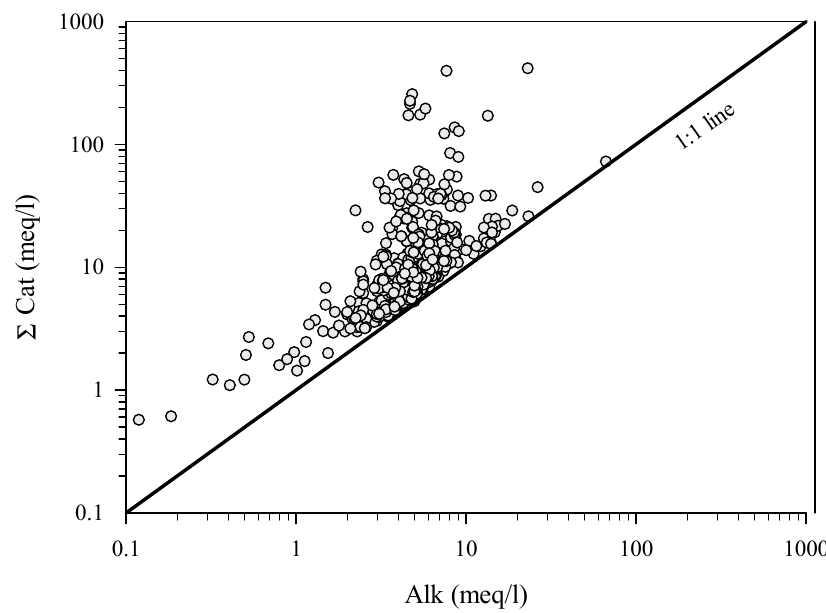
Figure 4. Sum of the cation equivalent versus total alkalinity (Alk). Data as meq/l in log scale.